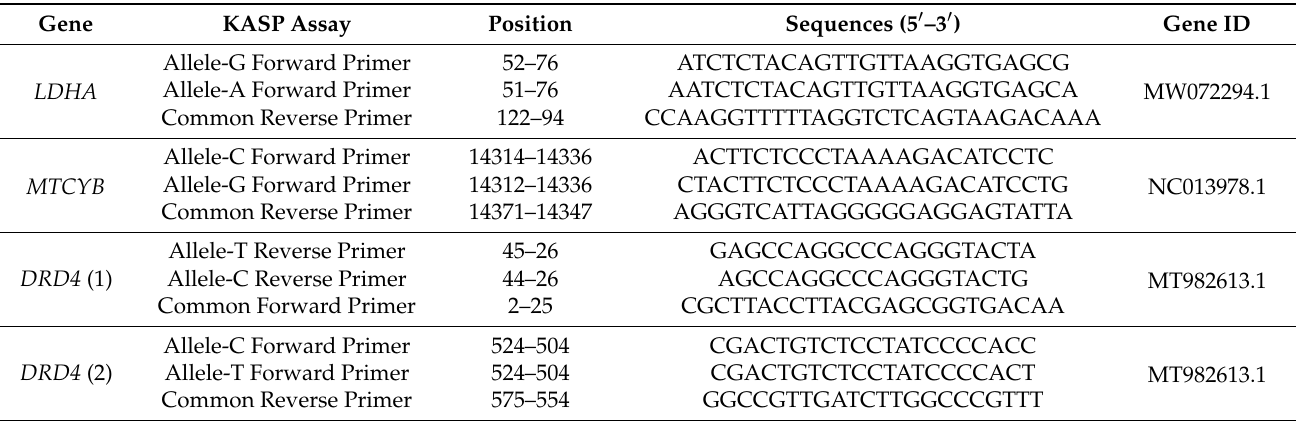
Table 2. Primer sequences for KASP